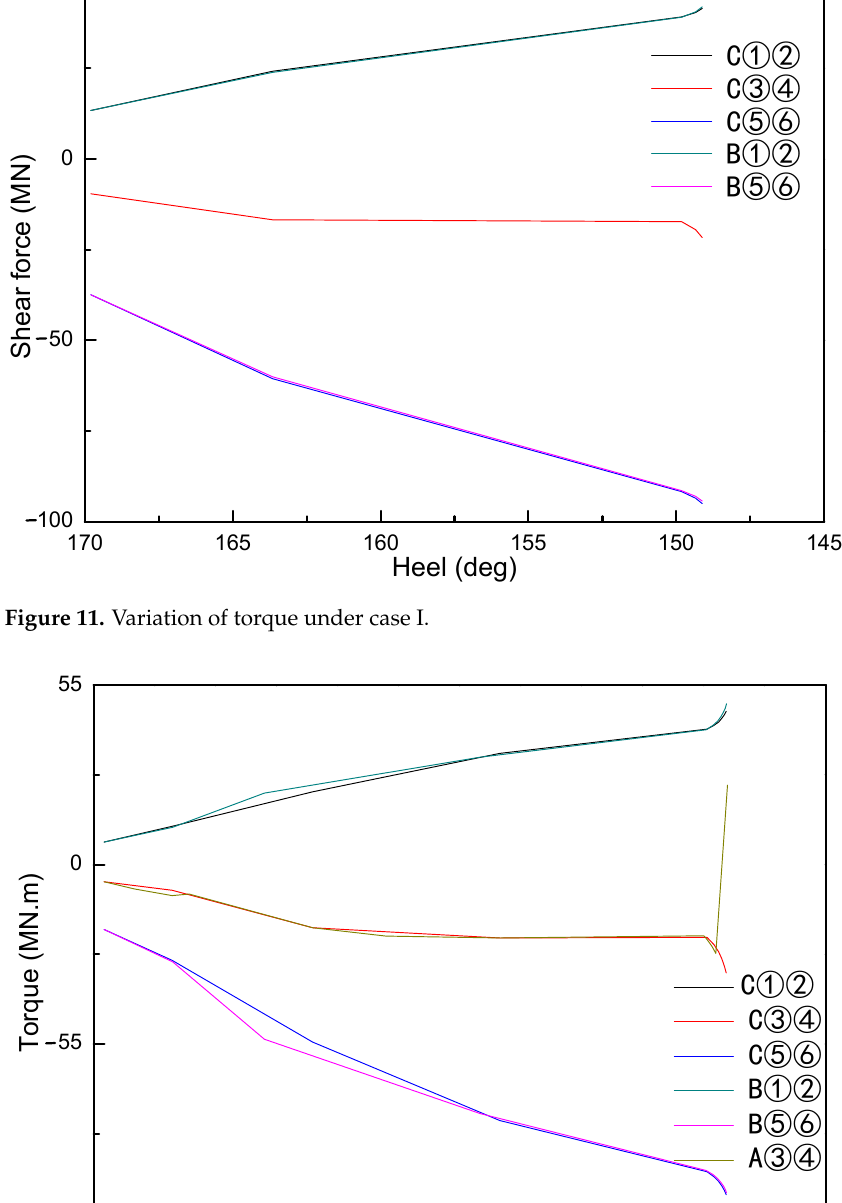
Through comparing the four cases, the torque difference of C 1 (cid:13) 2 (cid:13) and B 1 (cid:13) 2 (cid:13) increases when the heel angle decreases, the maximum difference is, respectively, 0.9%, 1.99%, 3.98% and 3.40%, and C 1 (cid:13) 2 (cid:13) is smaller than B 1 (cid:13) 2 (cid:13) . The torque difference of C 5 (cid:13) 6 (cid:13) and B 5 (cid:13) 6 (cid:13) increases when the heel angle decreases, and the maximum difference is, respectively, 0.77%, 1.54%, 3.10% and 2.94%, and C 5 (cid:13) 6 (cid:13) is smaller than B 5 (cid:13) 6 (cid:13) . The torque of C 3 (cid:13) 4 (cid:13) is larger than that of A 3 (cid:13) 4 (cid:13) , and the maximum difference is 6.02%. Analysis showed that multiple righting force points do not necessarily reduce torque